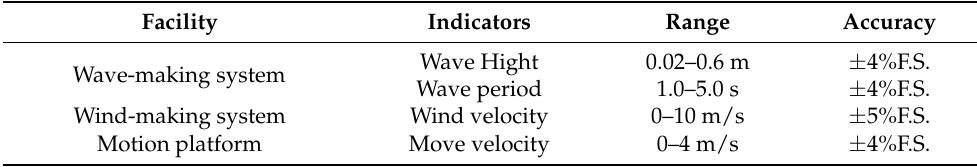
Table 3. The experimental equipment and main indicators of multi-functional wave-making basin. Facility Indicators Range Accuracy Wave-making system Wind-making system Wind velocity Motion platform Move velocity